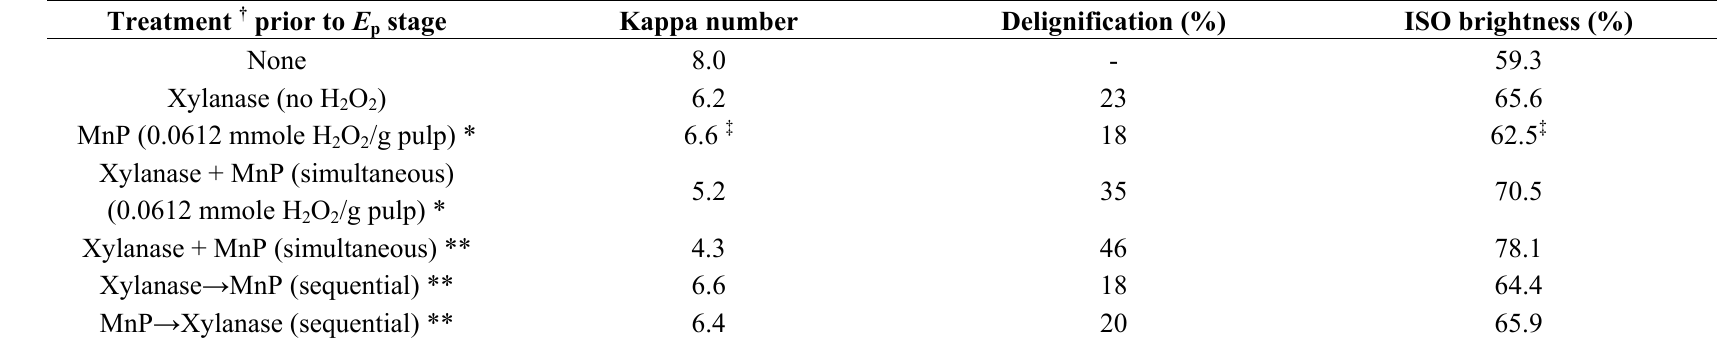
Table 4. Trichoderma reesei Xylanase and Trametes versicolor MnP Treatment of Hardwood Kraft Pulp. Adapted with permission of authors from Bermek et al.